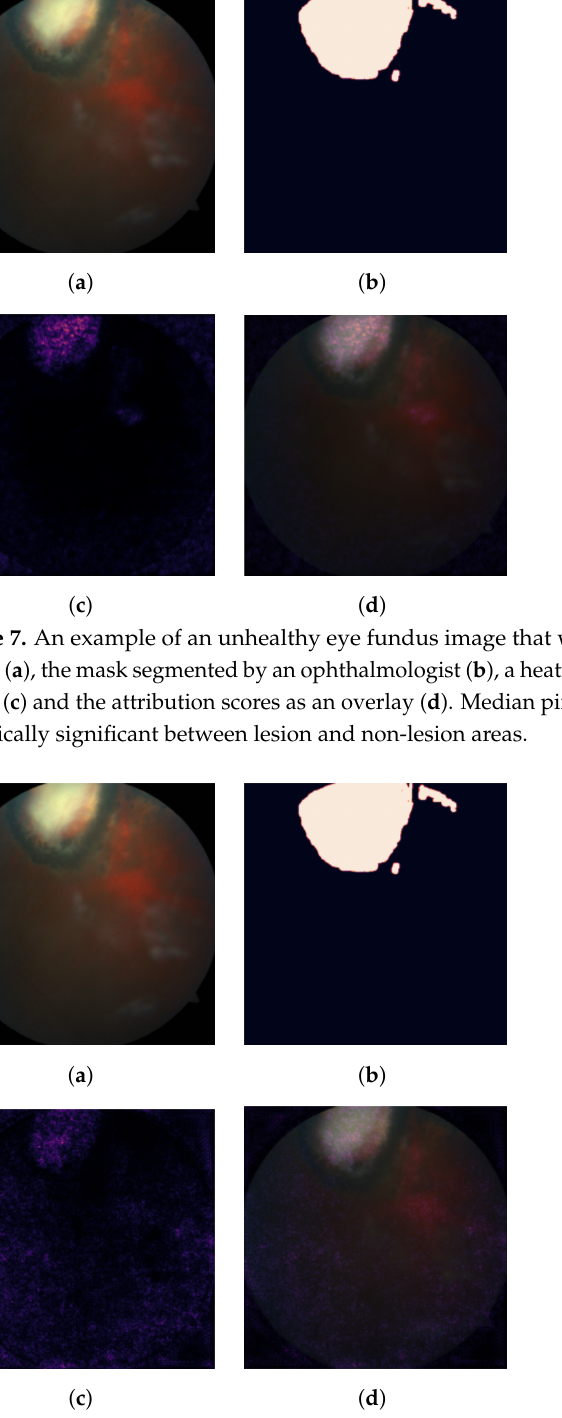
Figure 8. An example of an unhealthy eye fundus image that was correctly classified by the Resnet18 model ( a ), the mask segmented by an ophthalmologist ( b ), a heatmap of the IG-based pixel attribution scores ( c ) and the attribution scores as an overlay ( d ). Median pixel attribution score differences were not statistically significant between lesion and non-lesion